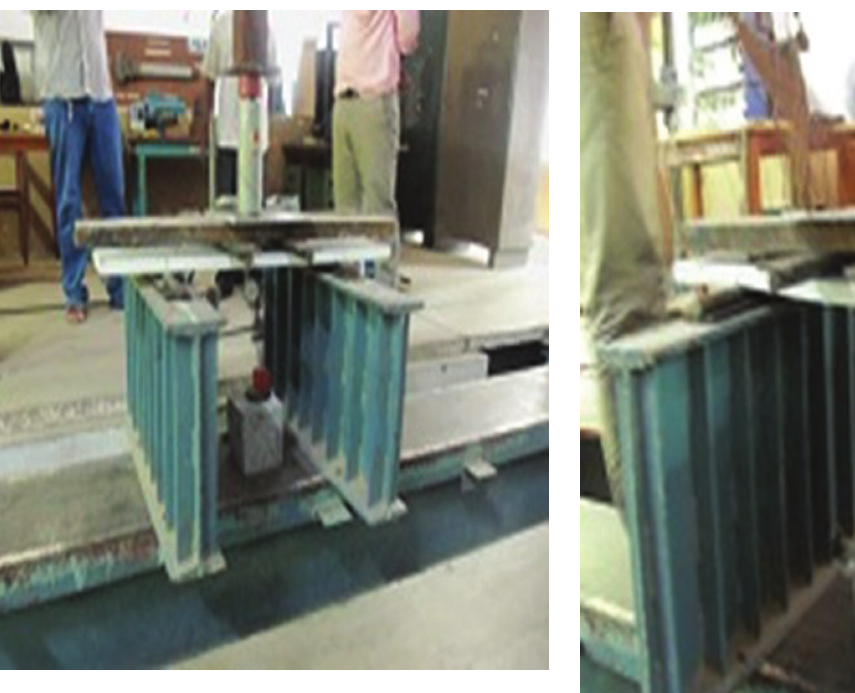
Figure 9 Flexure test setup.